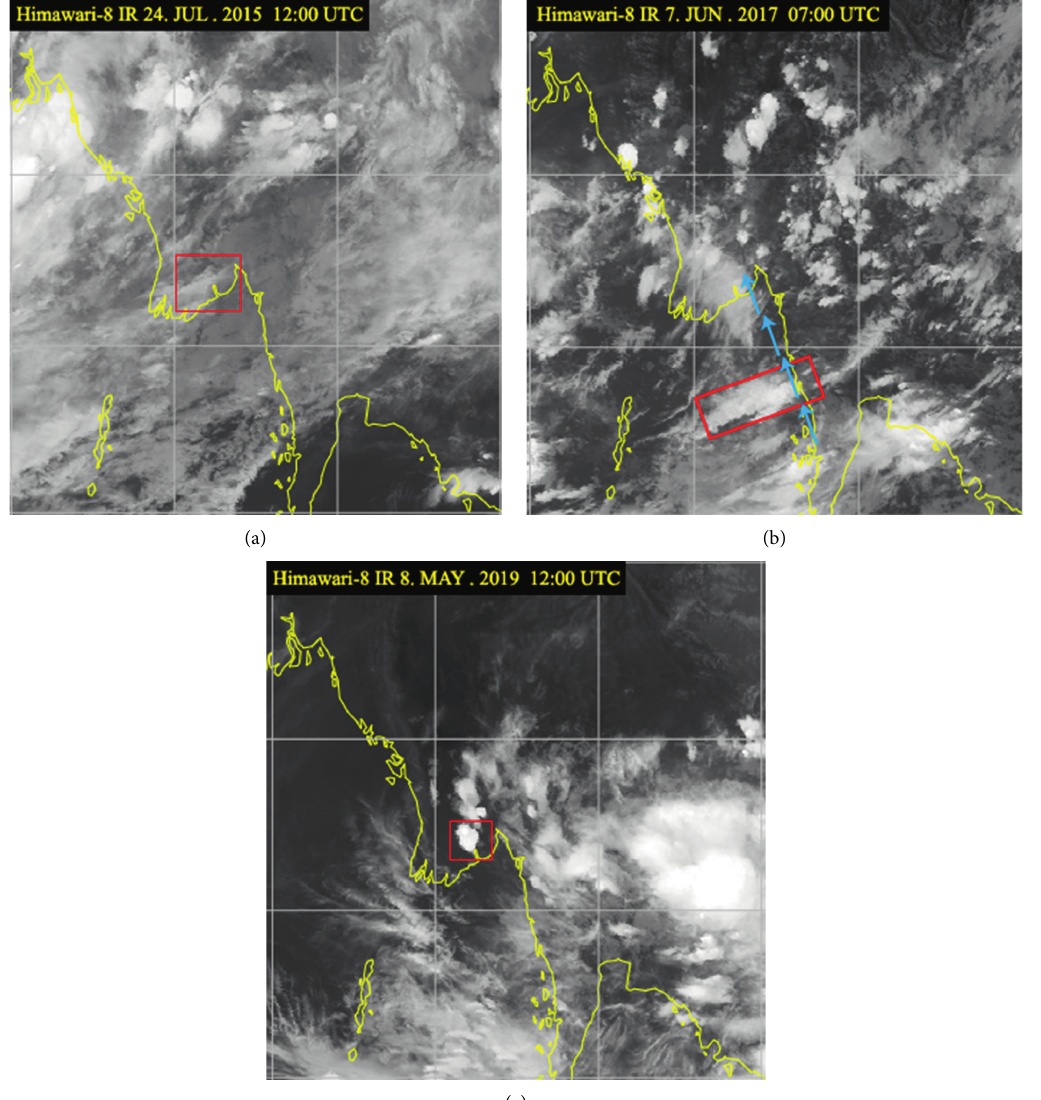
Figure 9: Actual thunderstorm cloud condition satellite image at a time of (a) Air Bagan ATR72, (b) Biman DHC-8-400, and (c) Y-8-200 FW aircraft’s